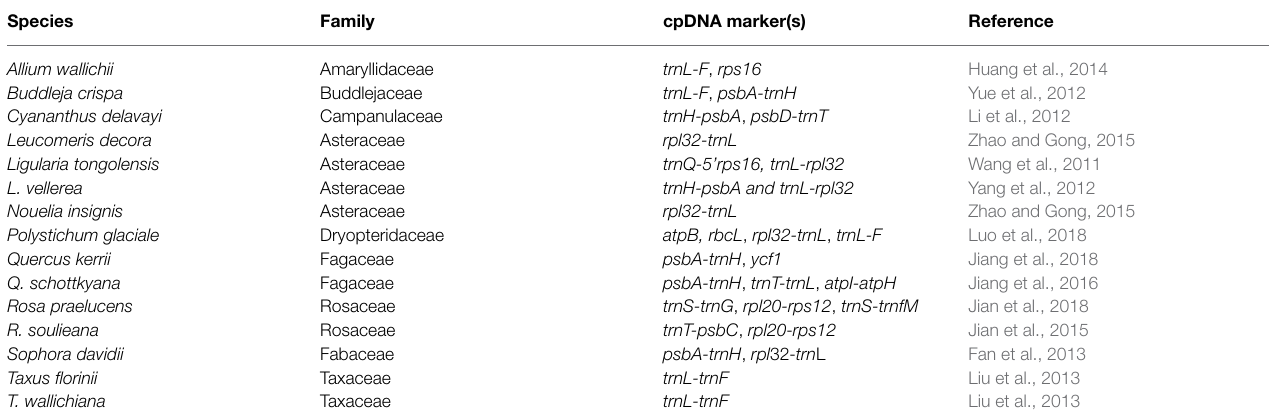
TABLE 1 | Details of the 15 plant species selected for analysis in the present